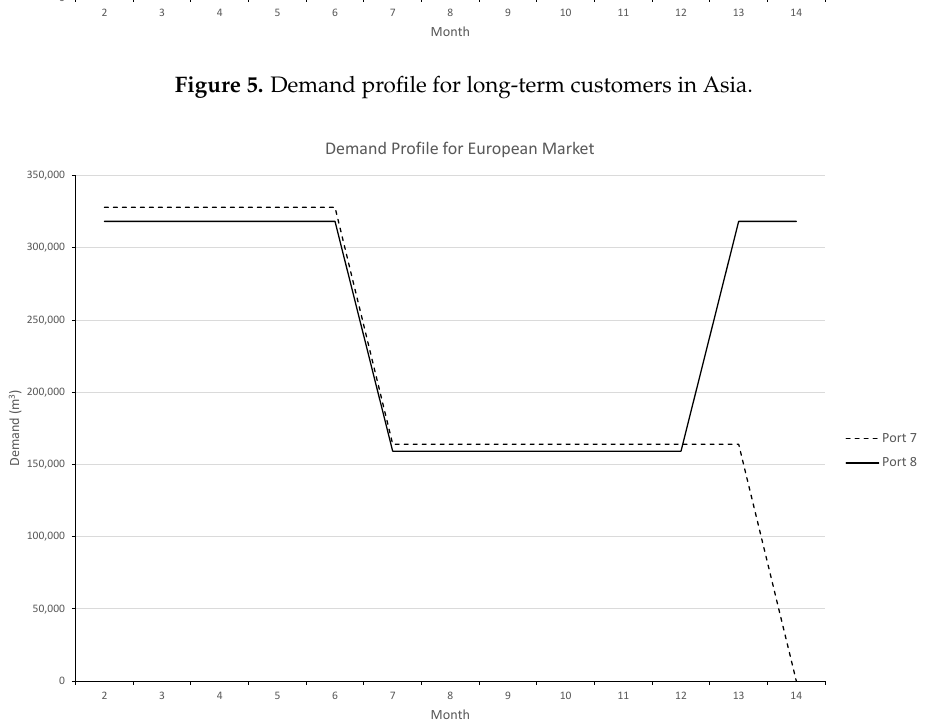
Figure 6. Demand profile for long-term customers in